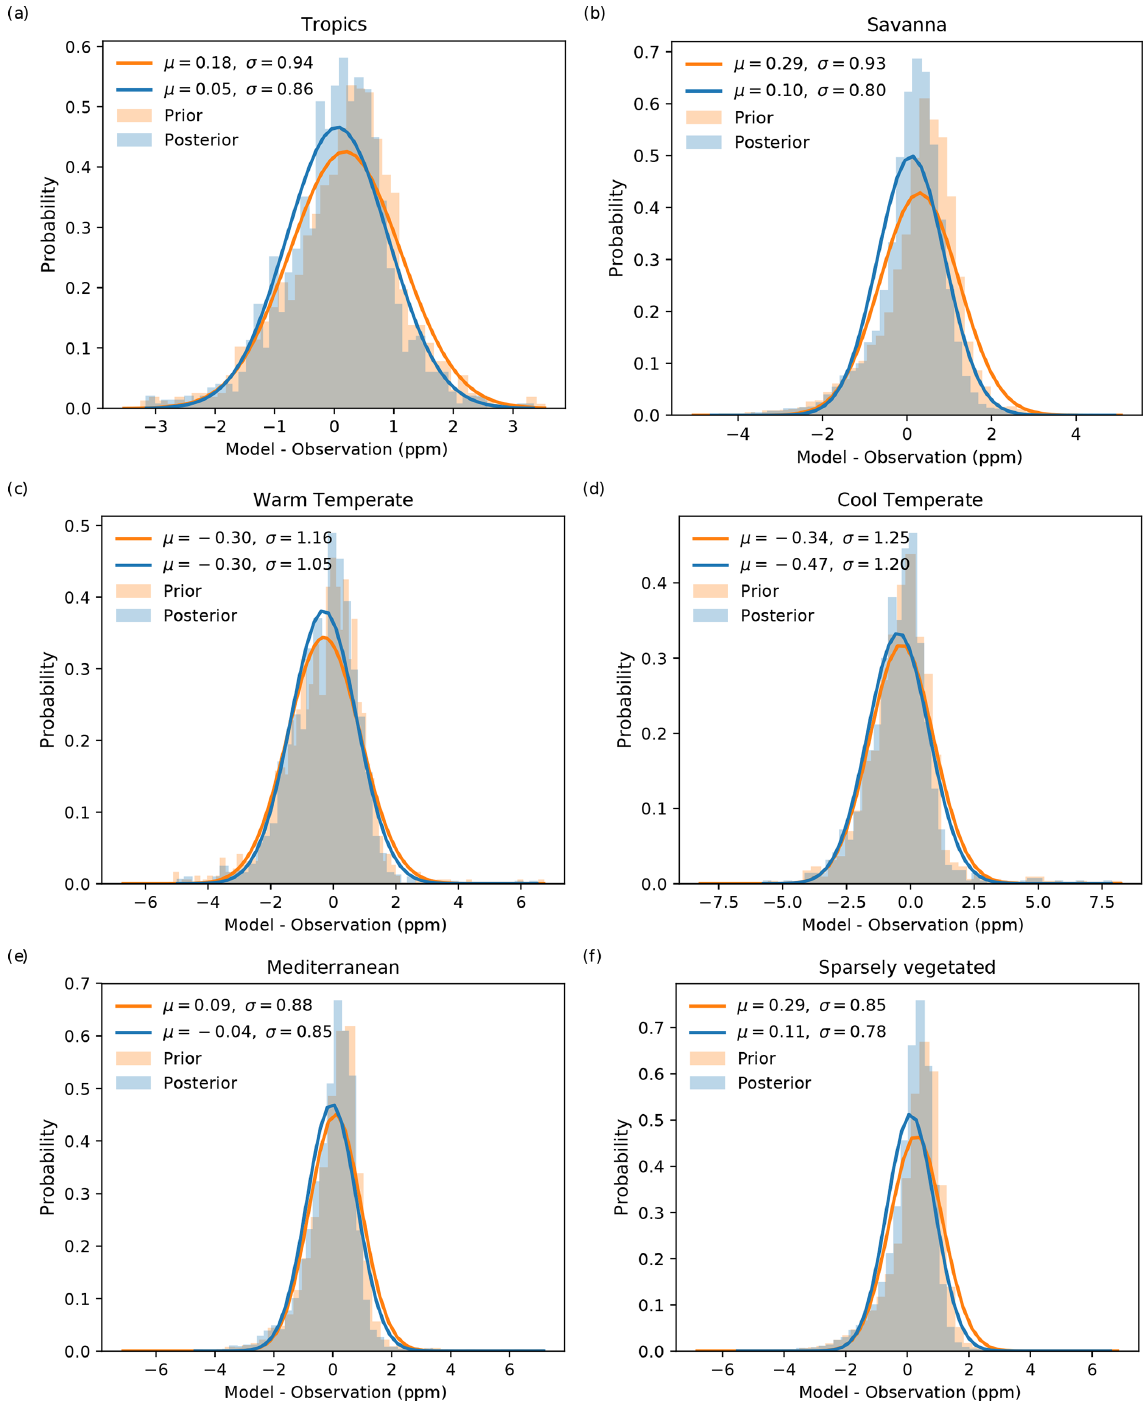
Figure A2. Probability density distribution of the difference between the CMAQ column-averaged CO 2 concentration and OCO-2 obser- vations aggregated by six bioclimatic classifications (in ppm). The orange histogram presents the prior CMAQ column-averaged simulated concentration minus OCO-2, whereas the blue histogram presents the posterior column-averaged simulated concentration minus the OCO-2. The mean differences and the RMSE are indicated in the